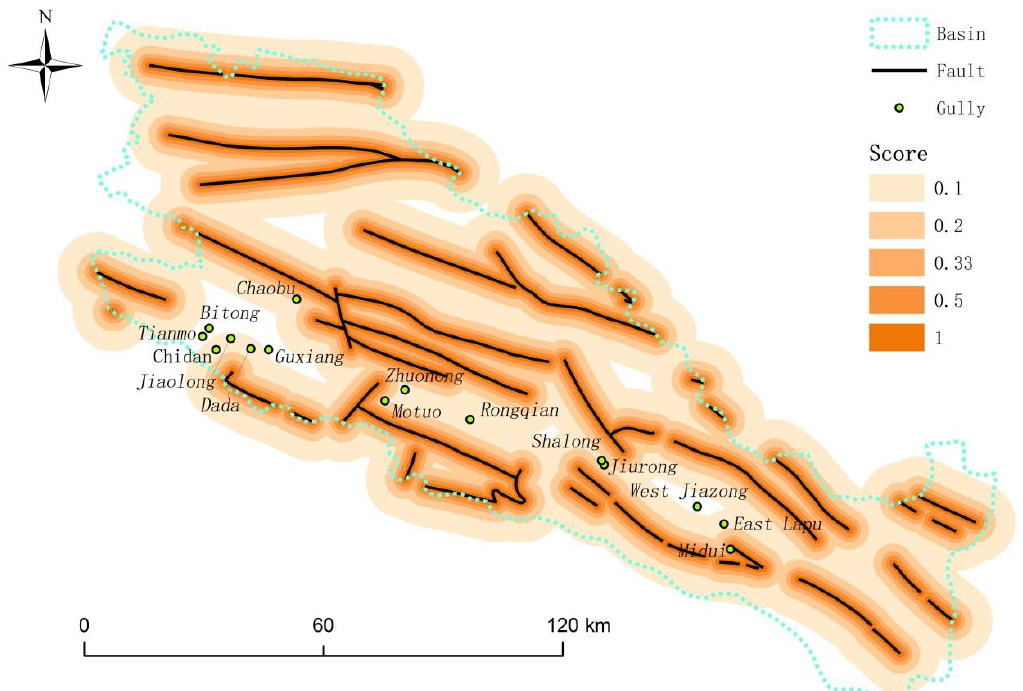
Figure 5. Distribution of faults and their buffers in the study area.